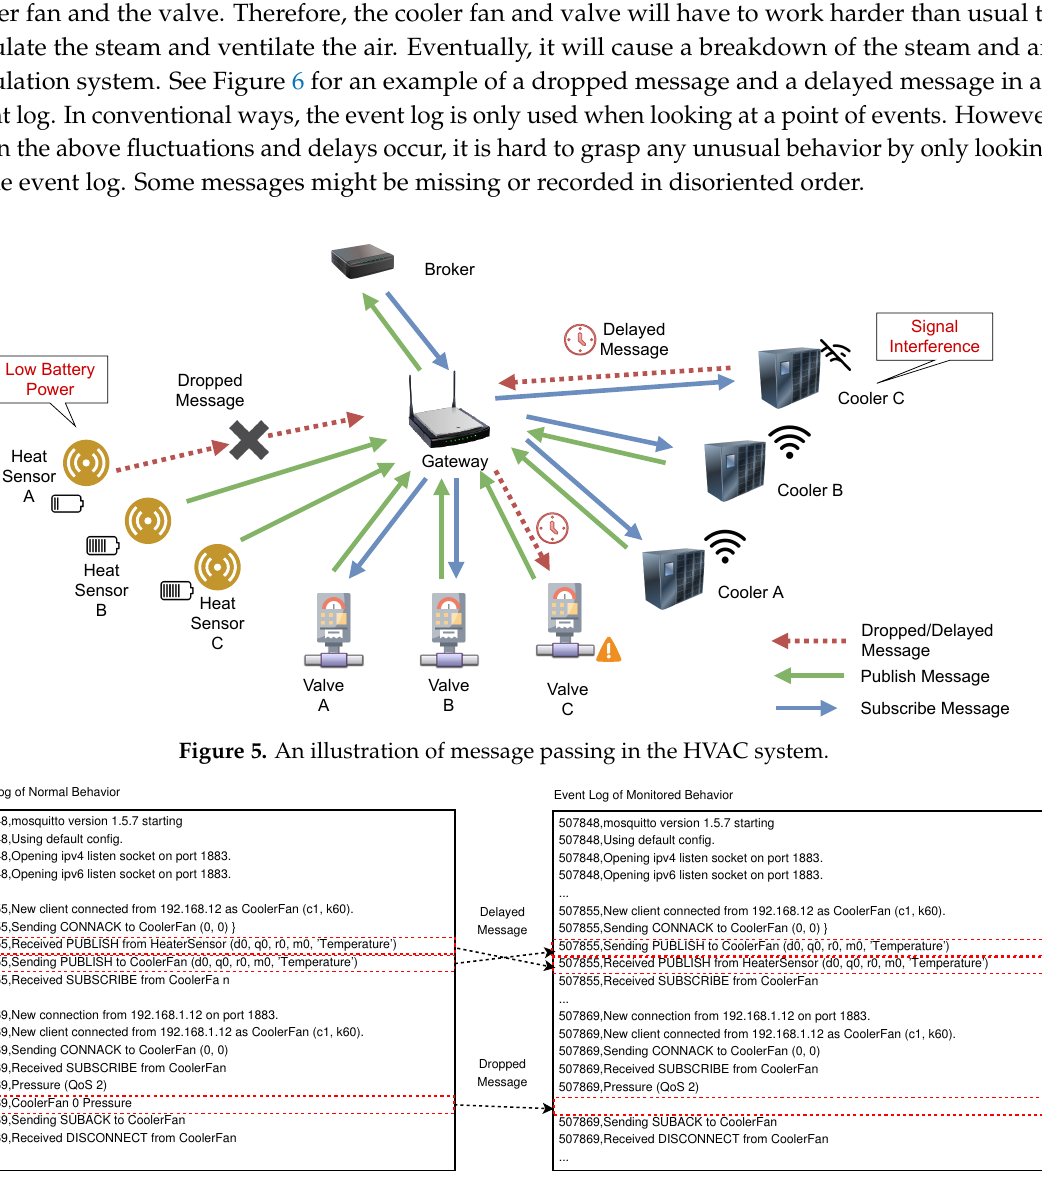
Figure 6. Event log of a message